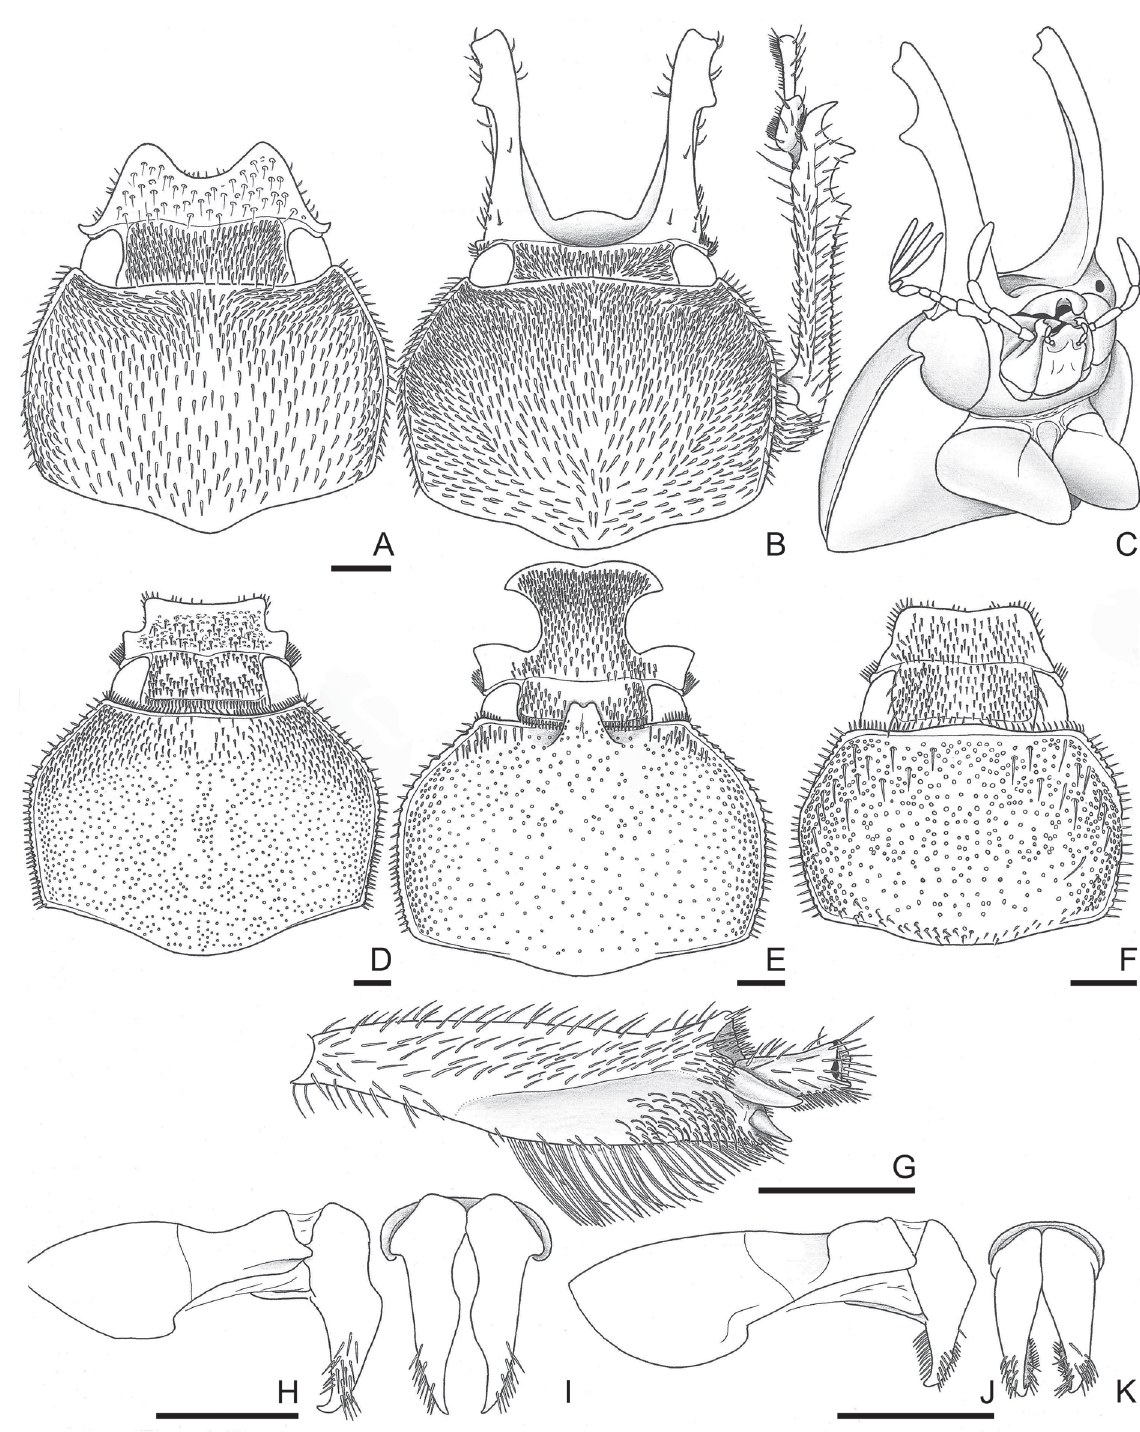
Fig. 10. A−B , D−F . Head−pronotum, dorsal. C . Head−prothorax, lateroventral. G . Metatibia, internal. A . ♀. B−G . ♂. H−K . Aedeagus (lateral, parameres apex). A−C , H−I . Ceratolontha venezuelae Arrow, 1948. D . Rhinaspis aenea Billberg, 1820. E . Rhinaspis ohausi Moser, 1921. F−G , J−K . Rhinaspis aeneofusca Moser, 1919. Scale bars = 1